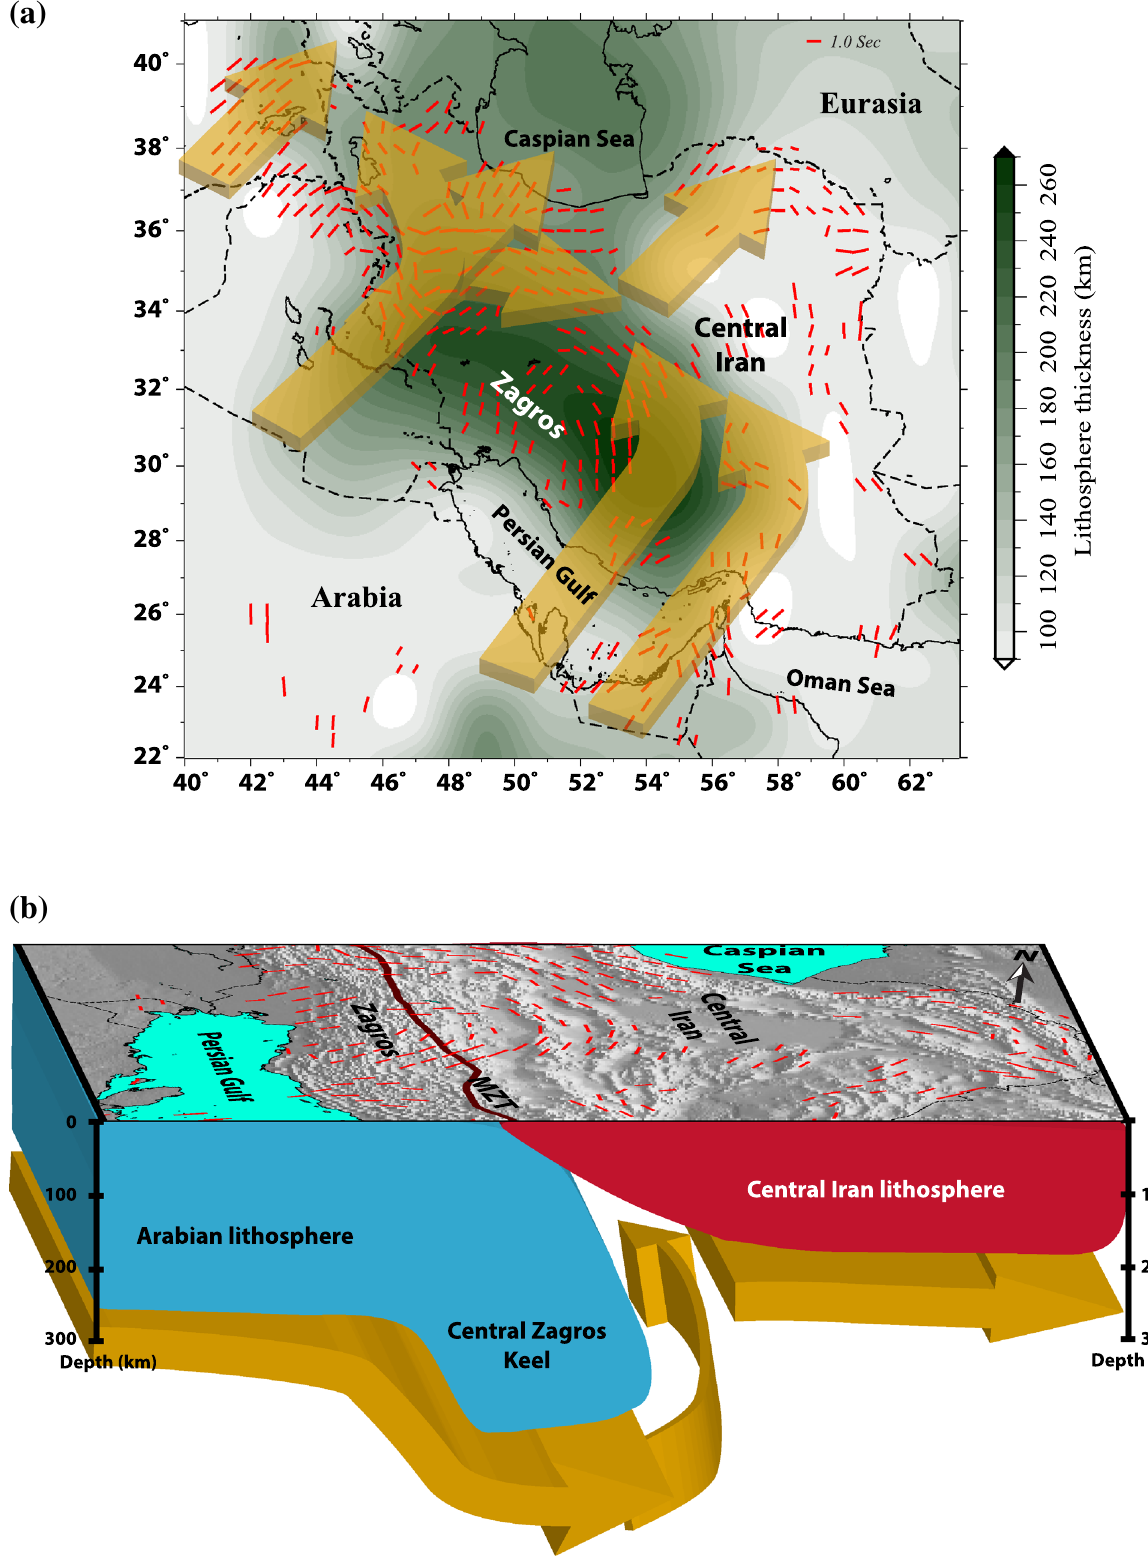
Figure 5. Schematic illustration of the model showing the possible circular mantle flow around the Zagros keel. ( A ) a map view and ( B ) a 3-D view of the proposed circular mantle flow. Figures are generated using the GMT 60 and Adobe